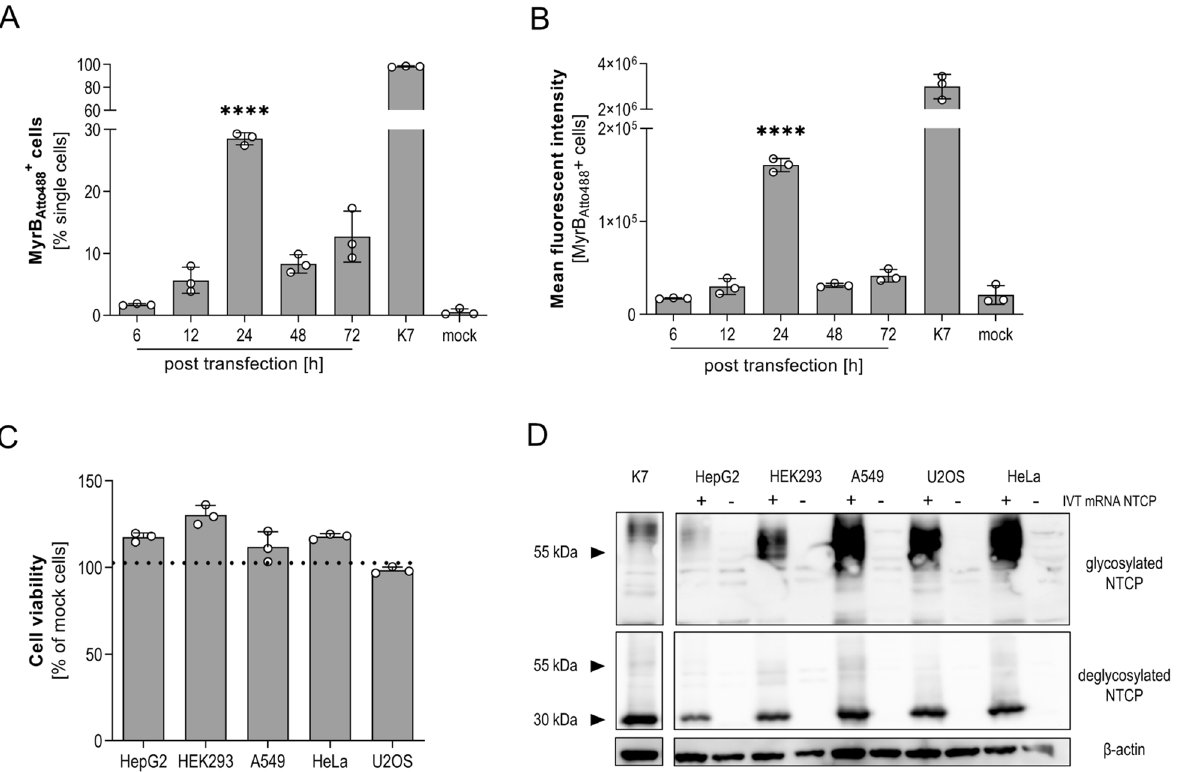
Figure 2. Expression of NTCP in different non-hepatic and hepatic cell lines after IVT mRNA transfection. ( A ) Differentiated HepG2 cells were transfected with 250 ng IVT mRNA expressing NTCP and analyzed by flow cytometry. Total number (left panel) and mean fluorescence intensity of NTCP expression using MyrB Atto488 staining (right panel) at indicated time points is given. HepG2-NTCP-K7 (K7) served as positive control. Mean ± SD of three biological replicates is shown. ( B ) 500 ng IVT mRNA NTCP was transfected into HepG2, HEK293, A549, HeLa and U2OS cells. Cytotoxicity was determined via CellTiter Blue assay 24 h post transfection. Mean percentage of viable cells ± SD of three biological replicates normalized to non-transfected control is given. ( C ) Western blot analysis 24 h post transfection of 500 ng IVT mRNA NTCP into respective cell lines. Expression of glycosylated and de-glycosylated proteins was compared. HepG2-NTCP-K7 cell line served as positive, respective parental cells as negative control. Statistical significance was determined using Welsh corrected Student’s t test (*p < 0.05, **p < 0.01, ***p < 0.001, ****p <